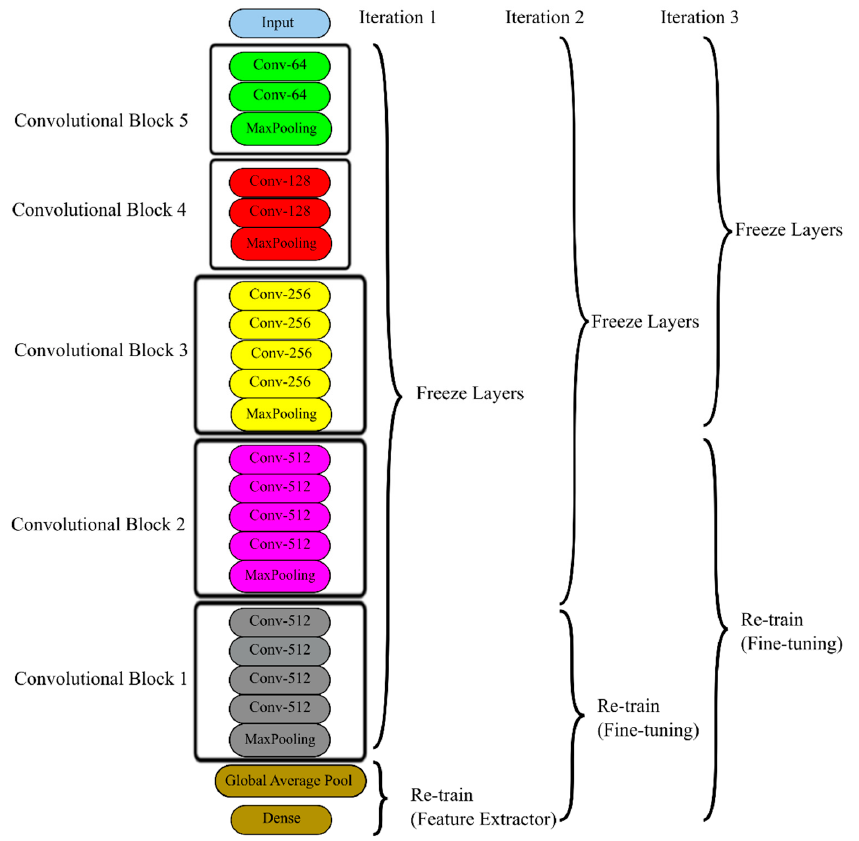
Figure 5 . VGG19 was retrained as a feature extractor and fine-tuned for better accuracy by retraining convolutional